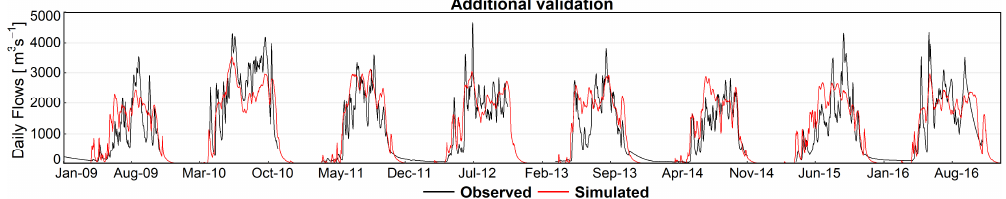
Figure 15. Daily observed streamflows (black) and simulated streamflows (red) produced by the improved rainfall dataset for additional validation of the RRI model at the Amalshid stream gauge during the entire study period (2009–2016). See Table 4 for the statistical metrics used to evaluate the simulated streamflows.